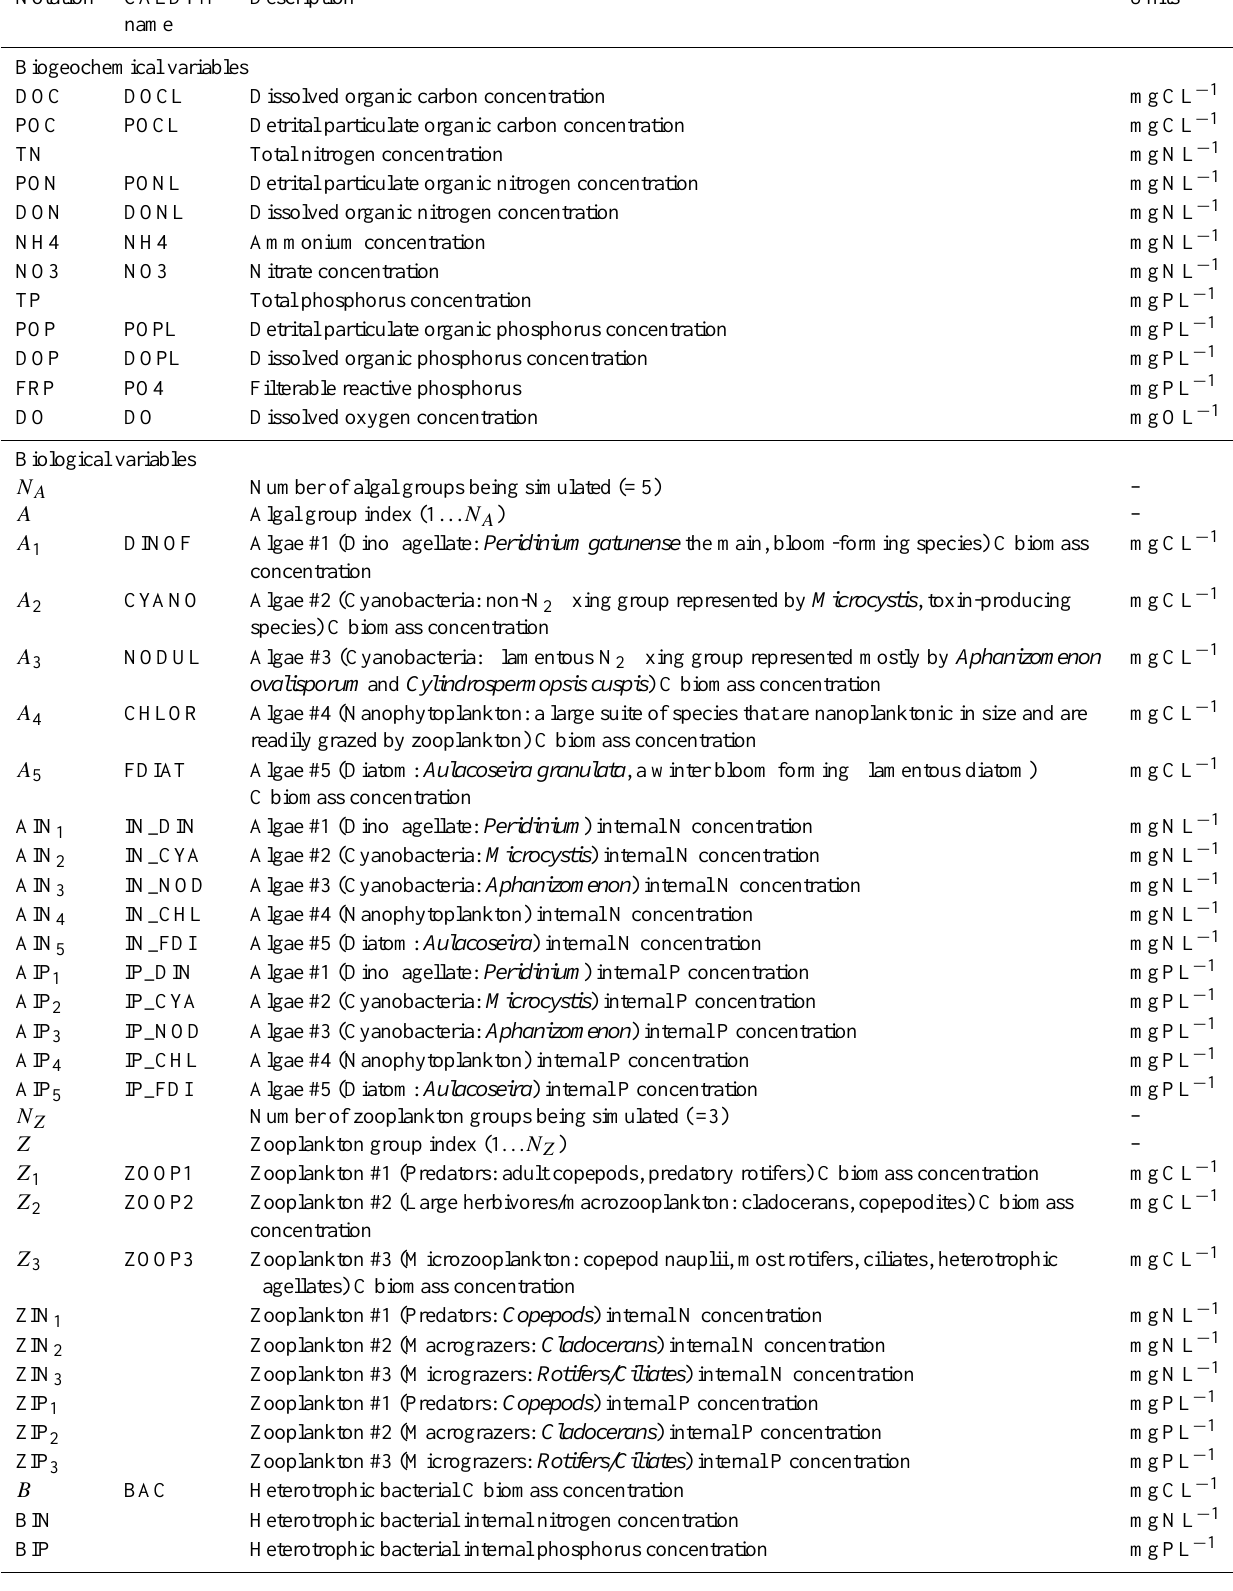
Table 1. Overview of model variables indicating CAEDYM state variable name where relevant.